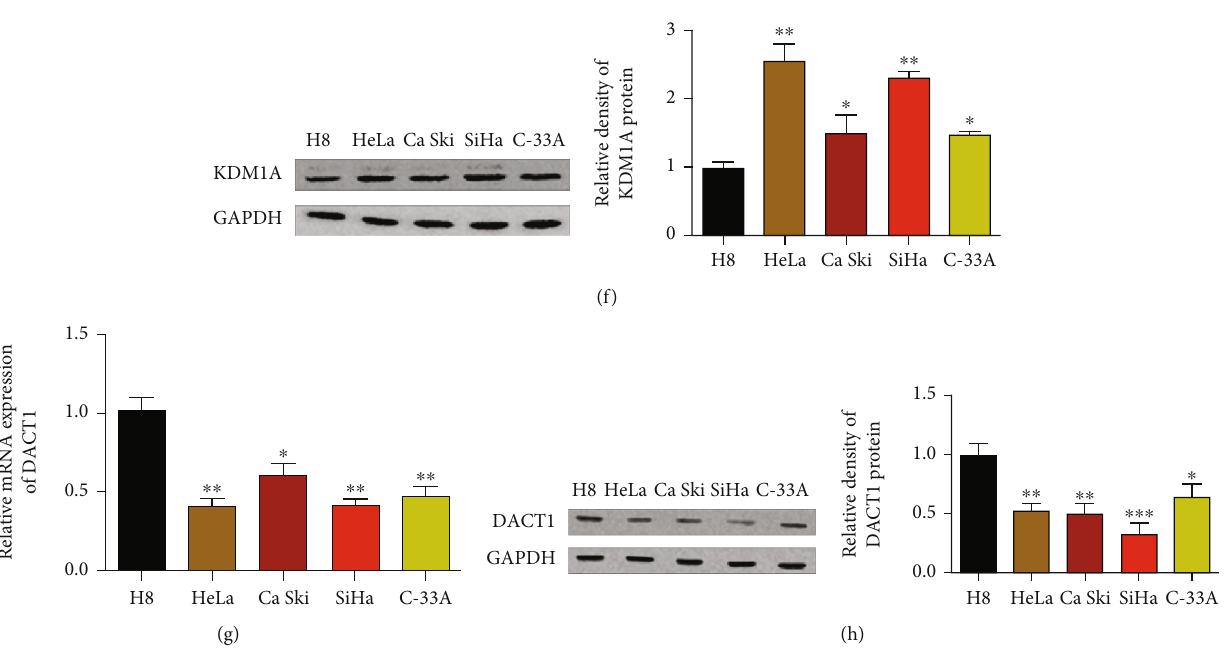
Figure 1: Measurement on expression pro fi le of KDM1A and DACT1 in cervical cancer tissues showed highly expressed KDM1A and lowly expressed DACT1 in cervical cancer tissues. (a) KDM1A expression level in cervical cancer tissues from TCGA database in UALCAN ( n = 305 ); (b) DACT1 expression level in cervical cancer tissues from TCGA database in UALCAN ( n = 305 ); (c) KDM1A expression level in cervical cancer in GEPIA database ( n = 306 ); (d) DACT1expression level in cervical cancer in GEPIA database ( n = 306 ); (e) mRNA expression level of KDM1A in cervical cancer cell lines HeLa, Ca Ski, SiHa, and C-33A and immortalized human cervical epithelial cell line H8; (f) protein expression level of KDM1A in cervical cancer cell lines HeLa, Ca Ski, SiHa, and C-33A and immortalized human cervical epithelial cell line H8; (g) mRNA expression level of DACT1 in cervical cancer cell lines HeLa, Ca Ski, SiHa, and C-33A and immortalized human cervical epithelial cell line H8; (h) protein expression level of DACT1 in cervical cancer cell lines HeLa, Ca Ski, SiHa, and C-33A and immortalized human cervical epithelial cell line H8; ∗ p < 0 : 05 , ∗∗ p < 0 : 01 , and ∗∗∗ p < 0 : 001 , compared with H8